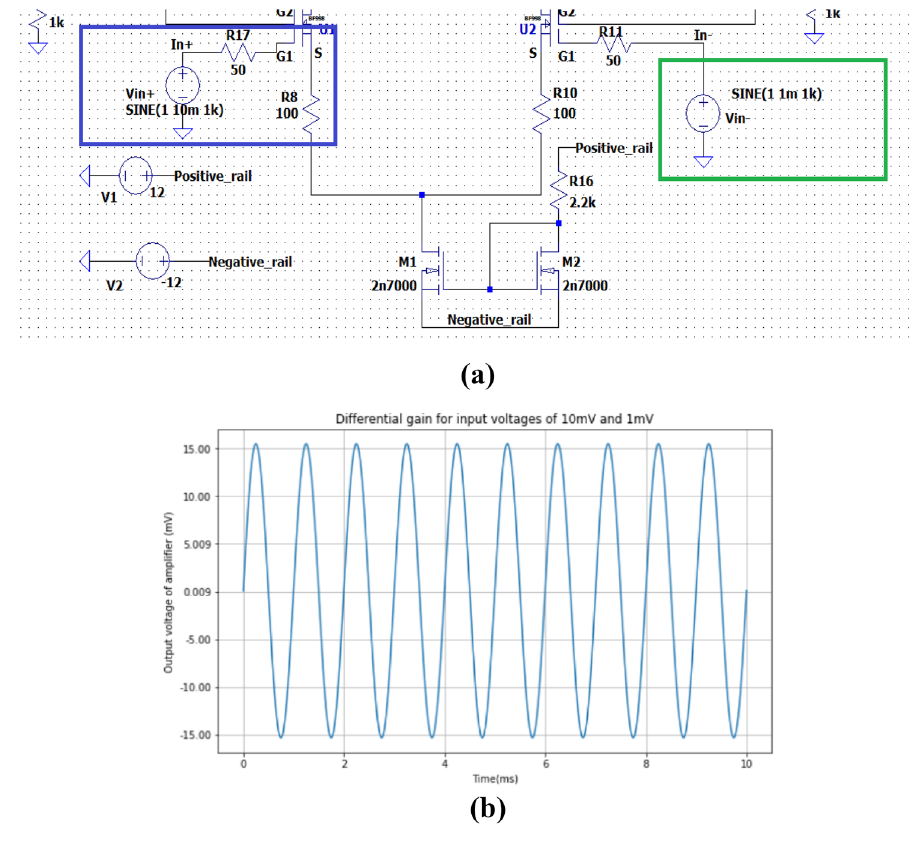
Fig. 7 a Simulation test setup to calculate differential voltage gain, showing Vin + (blue) and Vin-(green). b Differential output voltage for test setup shown in Fig. 7(a)